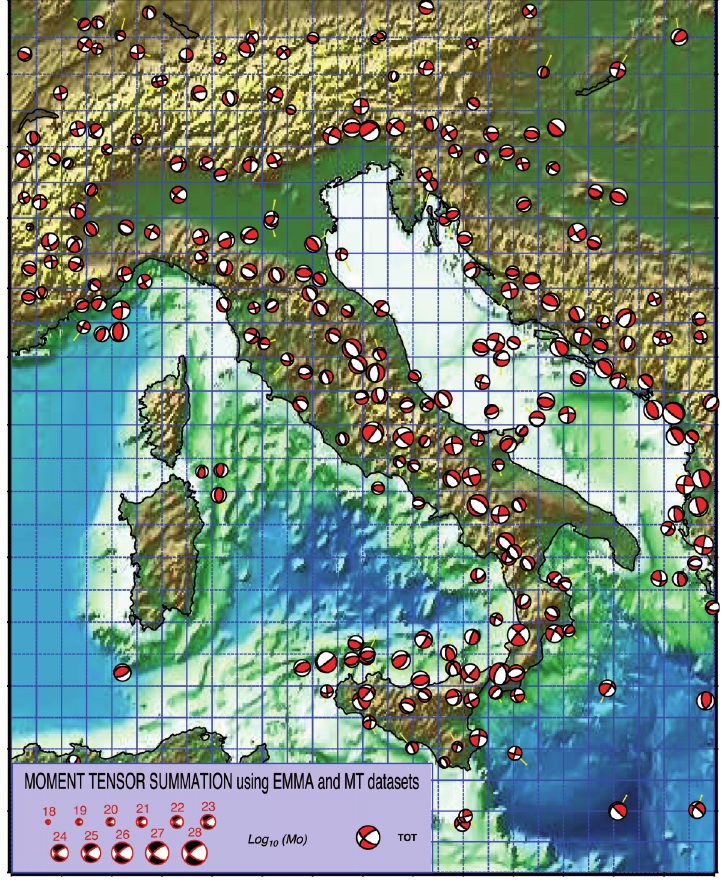
Fig. 5. Map showing the cumulative moment tensors on a regular grid with a mesh of half a degree, for earth- quakes with a depth <50 km (after Vannucci et al. ,